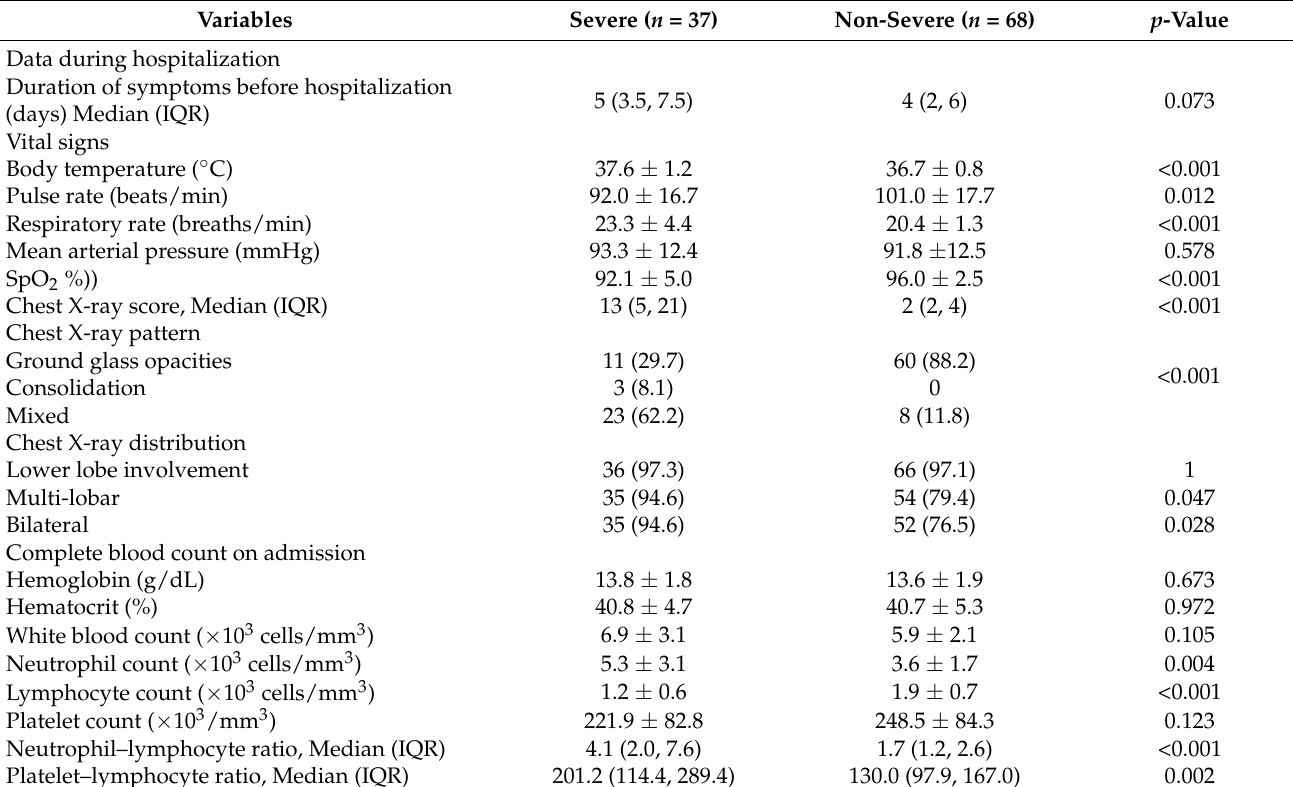
Table 2. Data during hospitalization ( n =